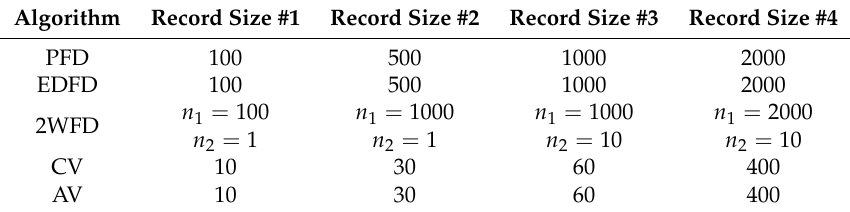
Table 6. Window sizes used by experiment on